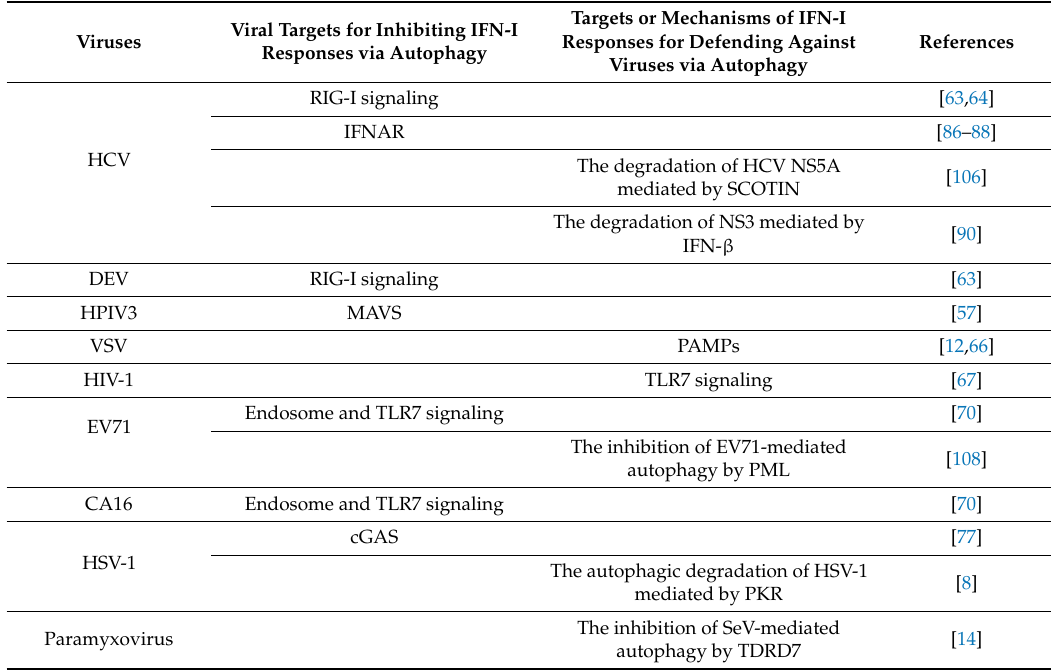
Table 1. The targets of virus-IFN-I-response interactions via autophagy. Autophagy as a pro-viral or antiviral tool is mediated by viruses and IFN-I responses, respectively, the molecular mechanisms of which are intricate. Some of the targets are summarized in Table